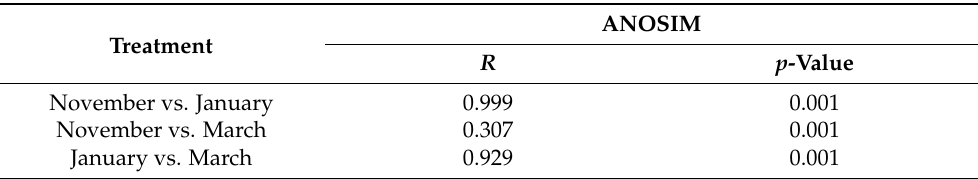
Figure 6. Food composition and intestinal bacterial community compositions of hooded cranes in the 3 months according to nonmetric multidimensional scaling (NMDS). ( A ) Food composition; ( B ) intestinal bacterial community compositions. Table 4. The analysis of similarities (ANOSIM) test was used to compare differences in the food composition of hooded cranes.